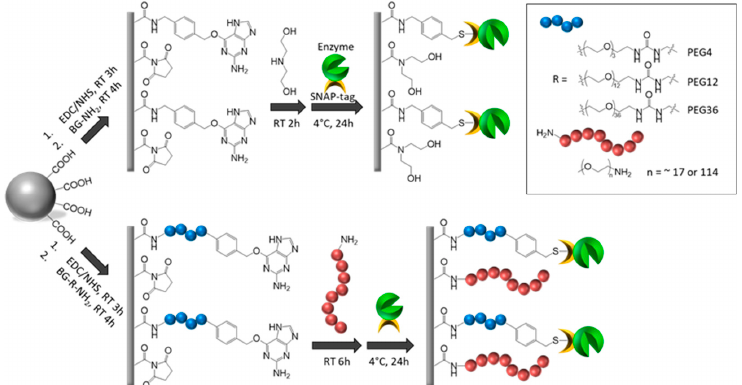
Figure 4. Schematic illustration of enzyme immobilization via SNAP-tag covalent conjugation onto bead surface functionalized with BG moiety and PEG coating.